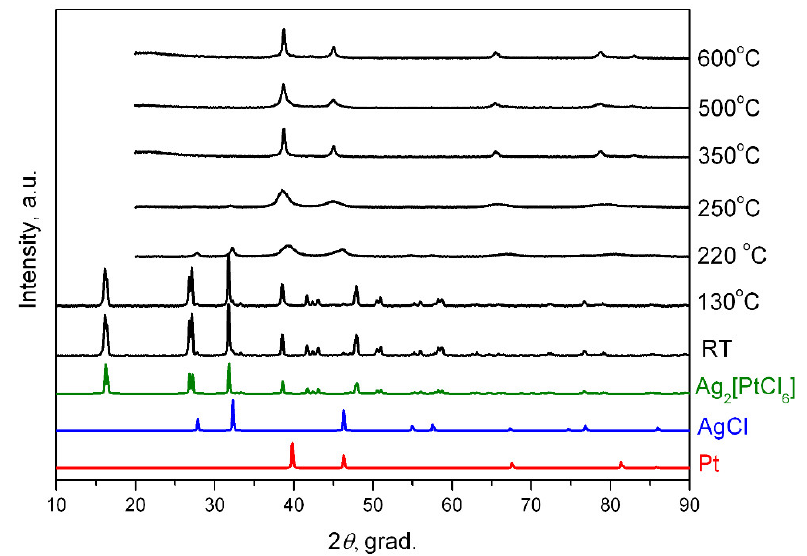
Figure 7. Diffraction patterns of Ag 2 [PtCl 6 ] and its thermolysis products in a hydrogen atmosphere at various temperatures. RT- room temperature.